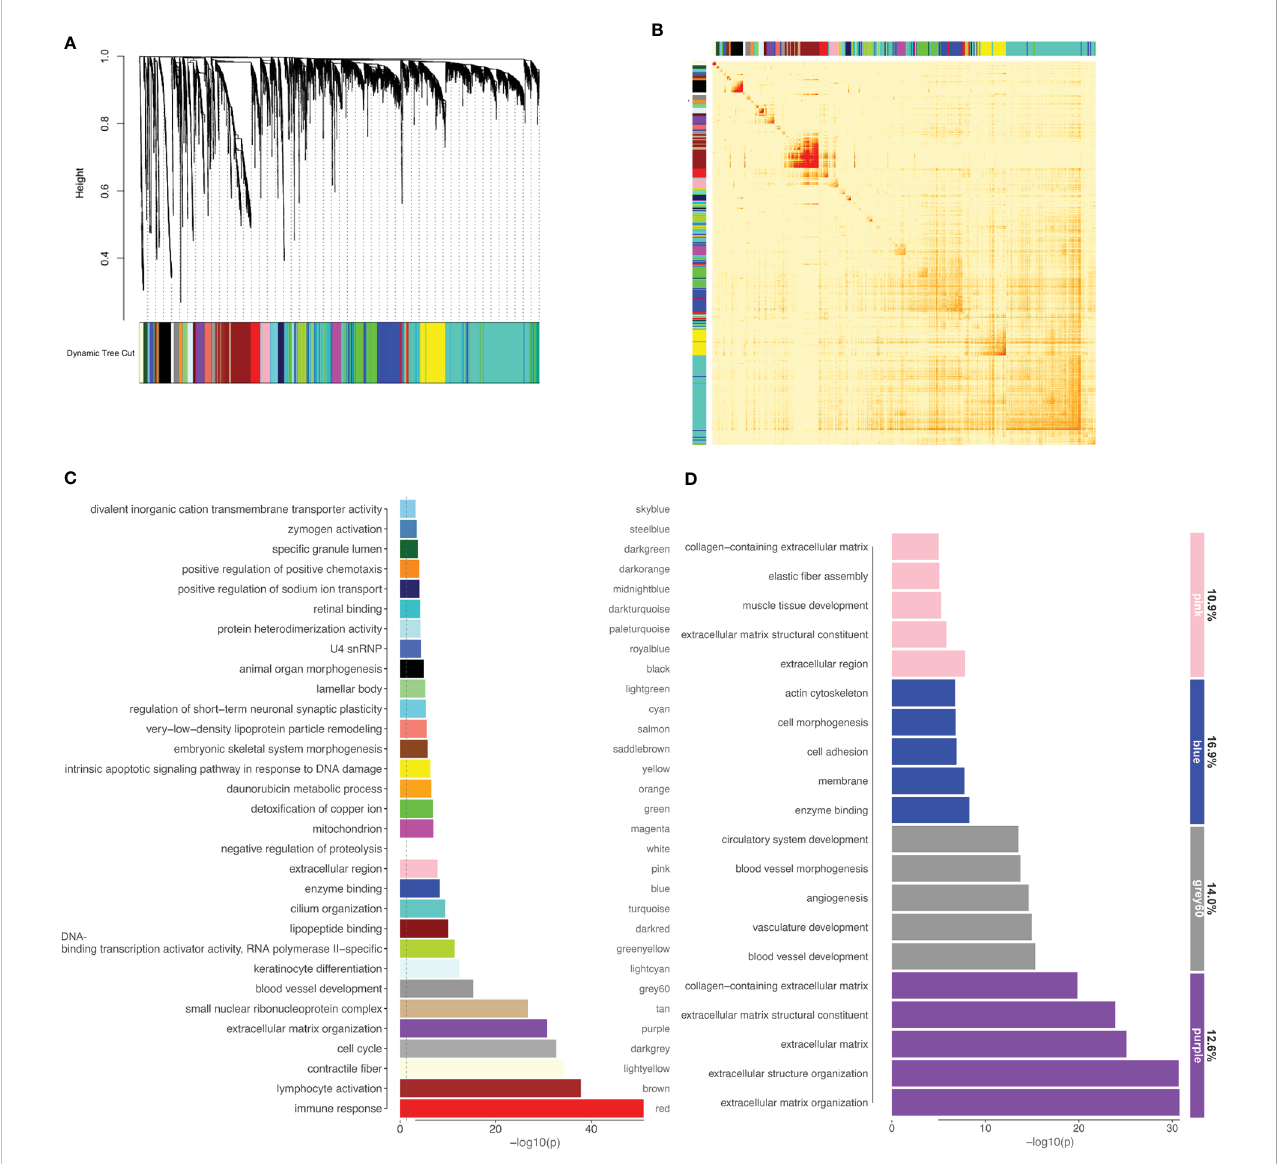
FIGURE 5 miR-495-3p target representation on WGCNA modules. (A) WGCNA dendrogram of differentially expressed genes (clustered based on 1-TOM) (B) Heatmap of the topological overlap matrix. Rows and columns correspond to single genes, light colors represent low topological overlap, and progressively darker orange and red colors represent higher topological overlap. (C) Bar plot shows the top enriched category for each module from WGCNA. (D) Bar plot shows GO enriched categories for WGCNA modules (>80 genes) with higher miR-495-3p target representation. Numbers on the right indicate the target representation for each